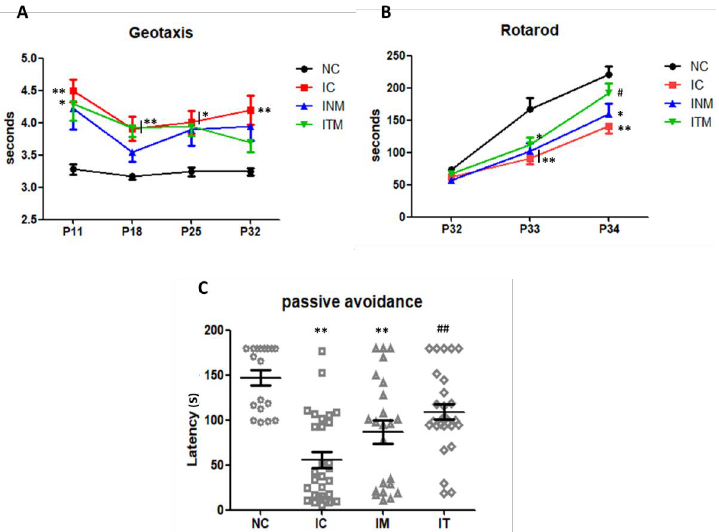
Figure 5. Improvement of the sensorimotor and memory functions in the rats with severe IVH after transplantation with thrombin-preconditioned MSCs. ( A ) Neurobehavioral functional outcomes in the negative geotaxis test, ( B ) rotarod test, and ( C ) passive avoidance test. ( n = 18, 29, 23, 28 in the NC group, IC group, INM group and ITM group, respectively) Data are expressed as means ± SEM. * p < 0.05 and ** p < 0.01 compared with the NC group, # p < 0.05 and ## p < 0.01 compared with the IC group. P, postnatal day; NC, normal control; IC, IVH control; INM, IVH with transplantation of naïve MSCs; ITM, IVH with transplantation of thrombin-preconditioned MSCs; IVH, intraventricular hemorrhage; MSCs, mesenchymal stem cells; SEM, standard error of the mean.